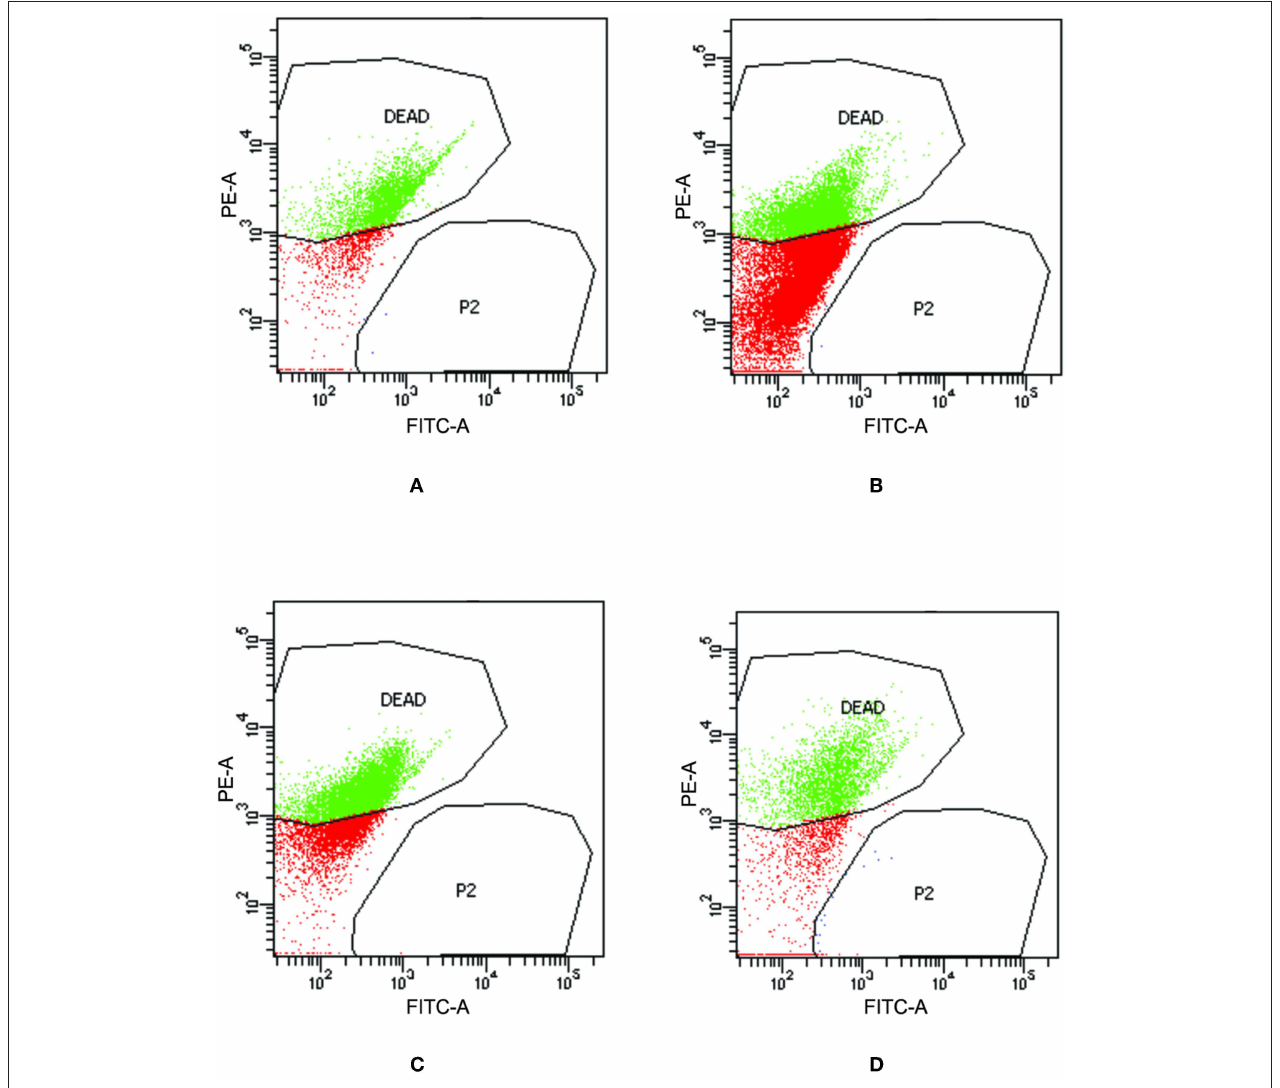
FIGURE 11 | Flow cytometry data showing the viability of K. pneumoniae upon treatment with (A) AiiA (B) Neat AgNPs (14.4 µ g/mL) (C) Azithromycin (1.87 µ g/mL) and (D) AgNP- AiiA complex (14.4 µ g/mL).